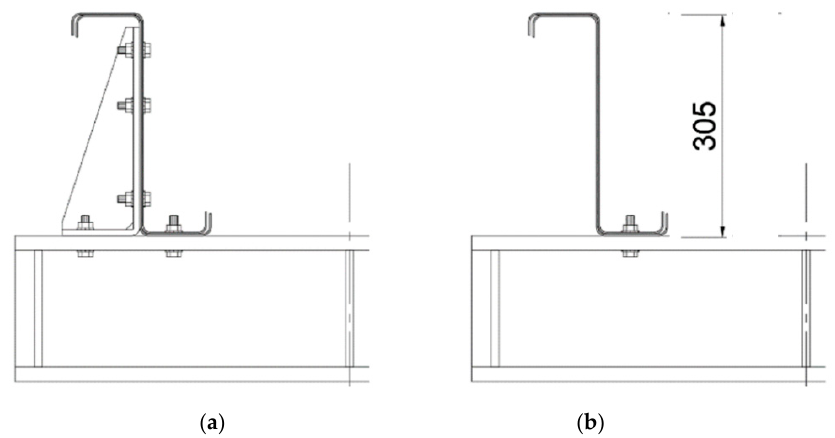
Figure 4. Support region cross-section details ( a ) with a clip and ( b ) without a clip.